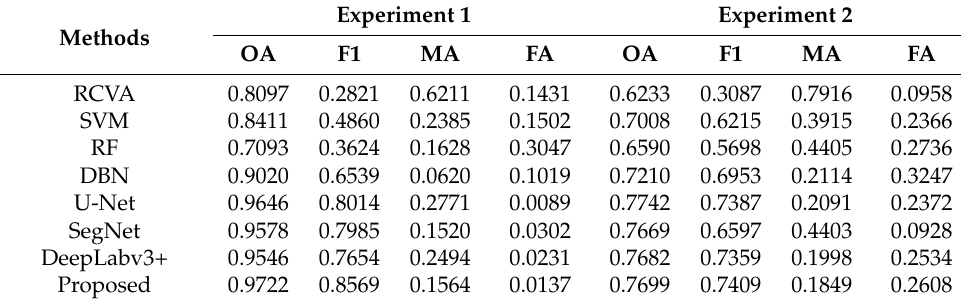
Table 6. Accuracy assessment on 2D change detection results.